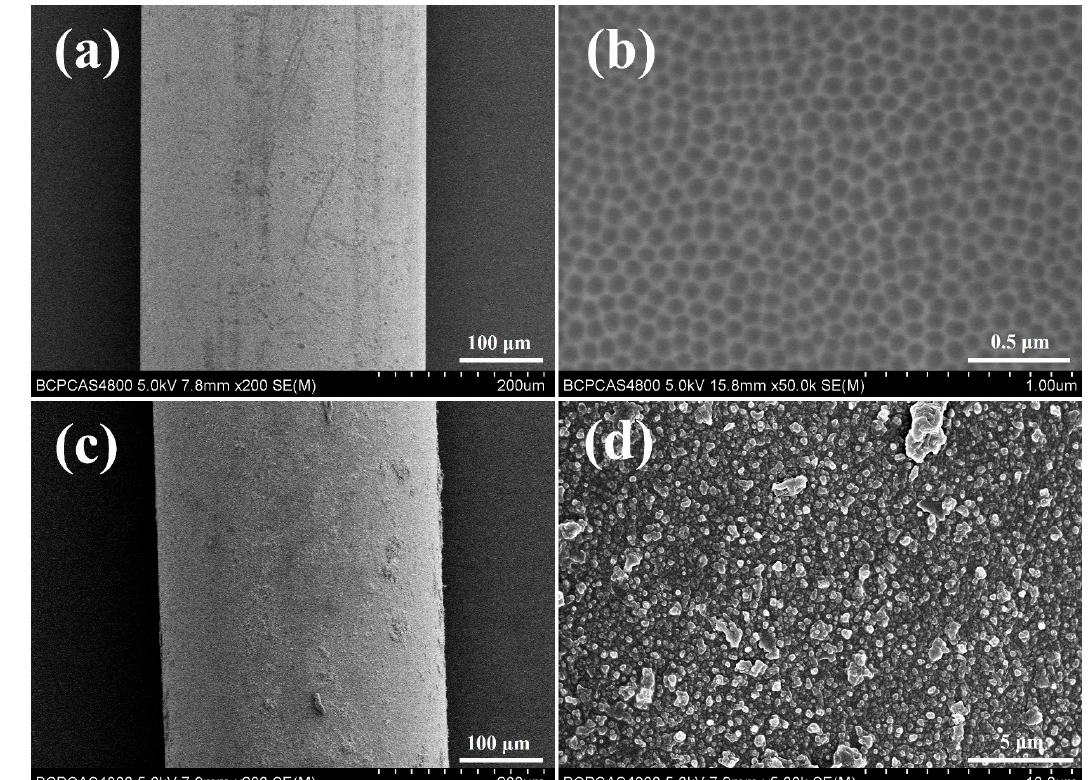
Figure 3. SEM images of AN-SSF with magnification at ( a ) 200 × and ( b ) 50,000 × ; SEM images of the COF-TpBD-bonded AN-SSF with magnification at ( c ) 200 × and ( d ) 5000 × .